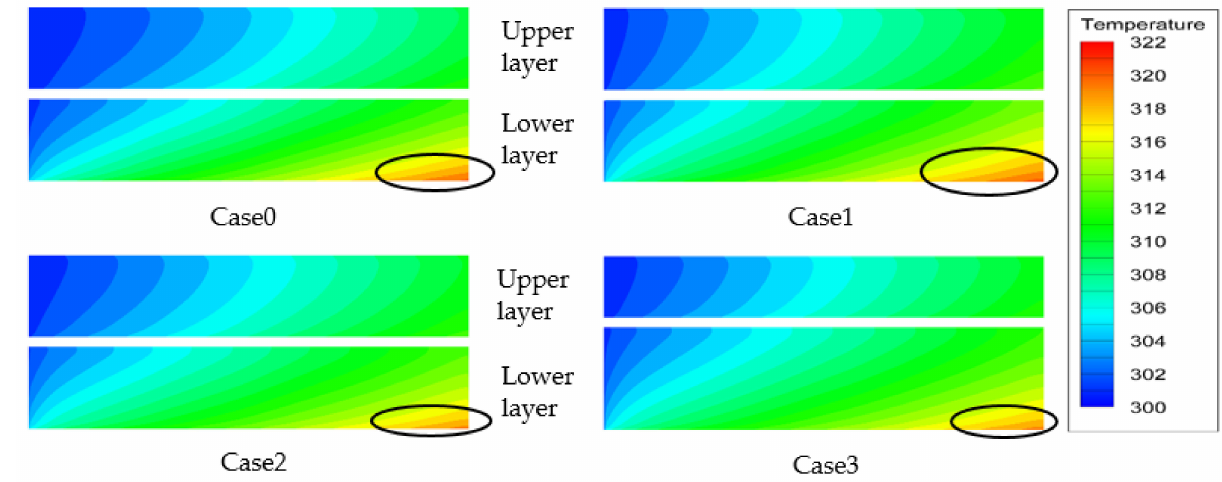
Figure 9. Temperature distribution on the substrate of the four cases ( u in = 0.75 m/s).